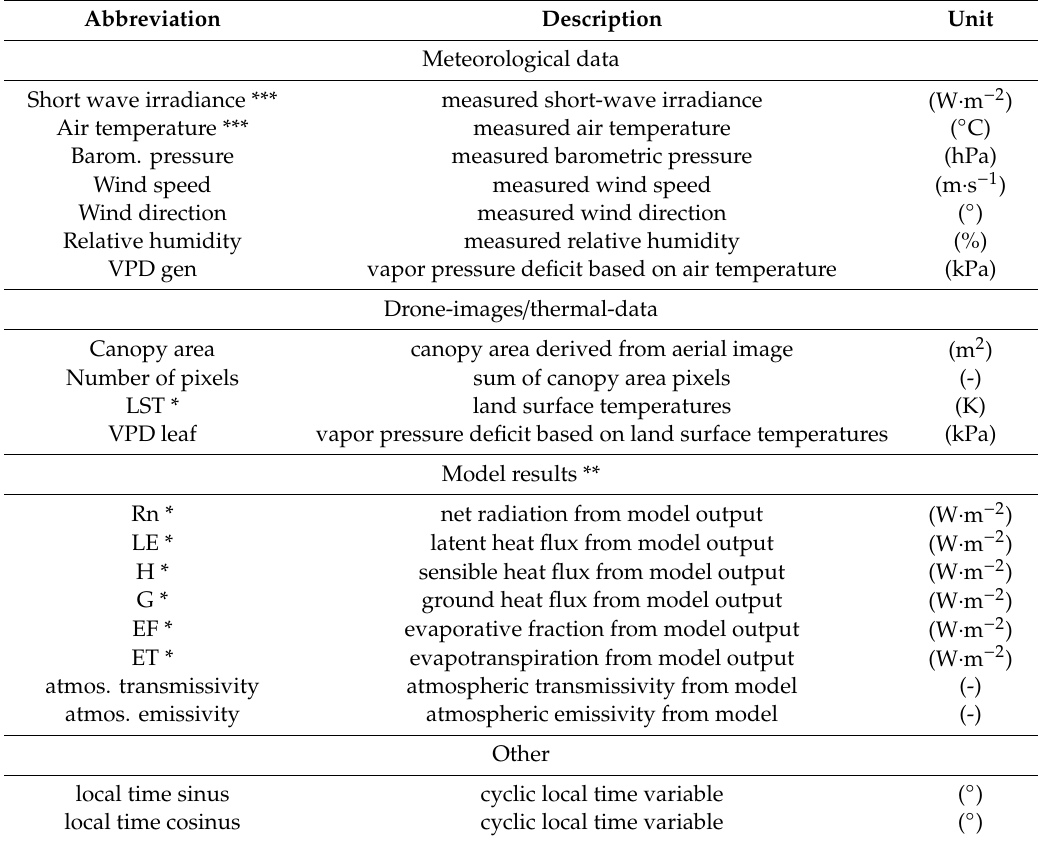
Table 2. Input variables, abbreviations and